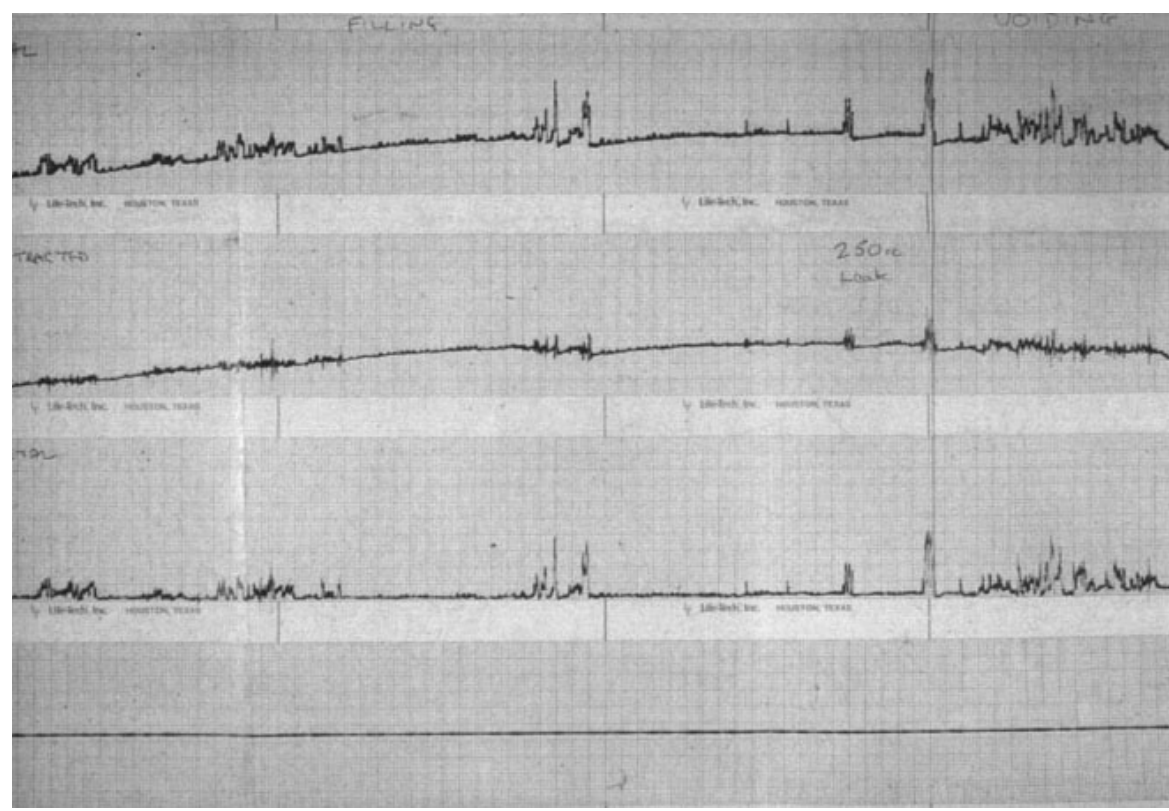
FIGURE 3. Forty-seven year old man with urinary incontinence; he had a history of low anterior resection of the colon and subsequent urinary incontinence. Incontinence worsened after TUR of prostate. Note steep filling cystometrogram (end-filling pressure of 200 mL, 60 cm H2O). Poor flow and intermittent pattern suggesting abdominal strain to